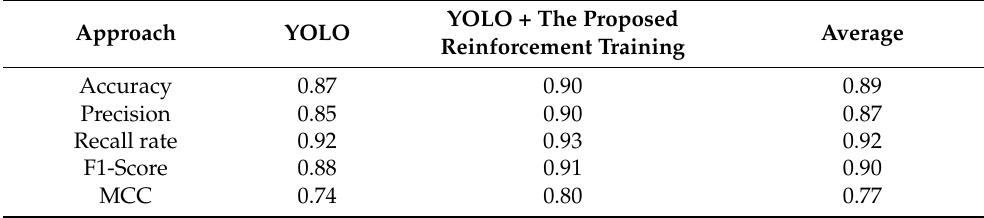
Table 3. Results of the trained